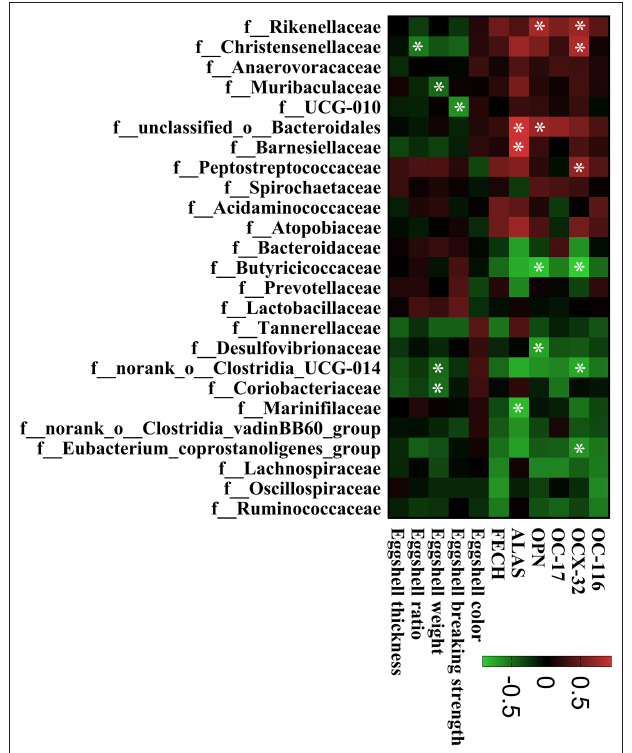
FIGURE 4 | The correlation between the cecal bacterial communities and gene expression of eggshell gland, eggshell quality. The lattices were colored based on Spearman’s rank correlation analysis. The red lattice indicates a positive correlation and the green lattice indicates a negative correlation. The asterisk symbol (*) means a significant correlation ( P <